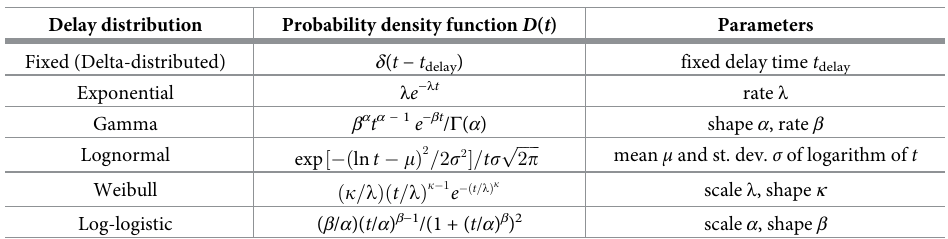
Table 1. Stylized delay distributions, D ( t